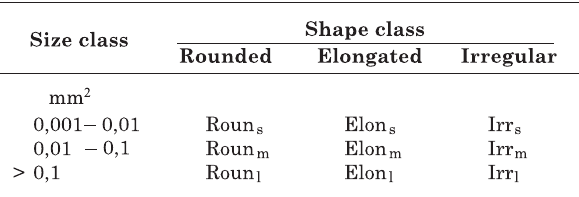
Table 2. Definition of the size and shape classes of the